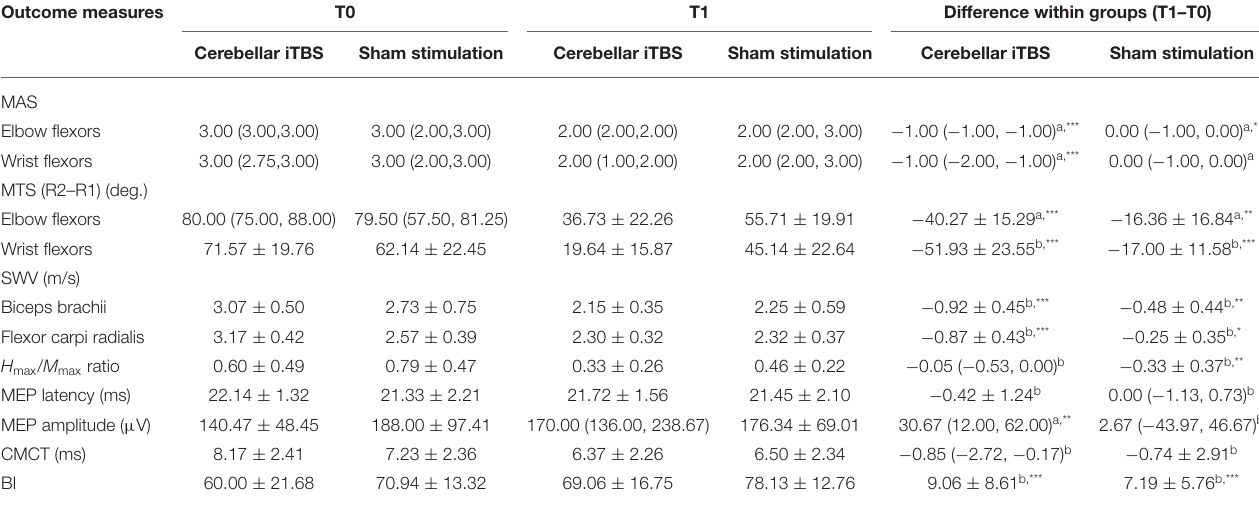
TABLE 2 | The descriptive data for all outcome measures in both groups at T0 and T1. Outcome measures T0 T1 Difference within groups (T1–T0) Cerebellar iTBS Sham stimulation Cerebellar iTBS Sham stimulation Cerebellar iTBS Sham stimulation MAS Elbow flexors